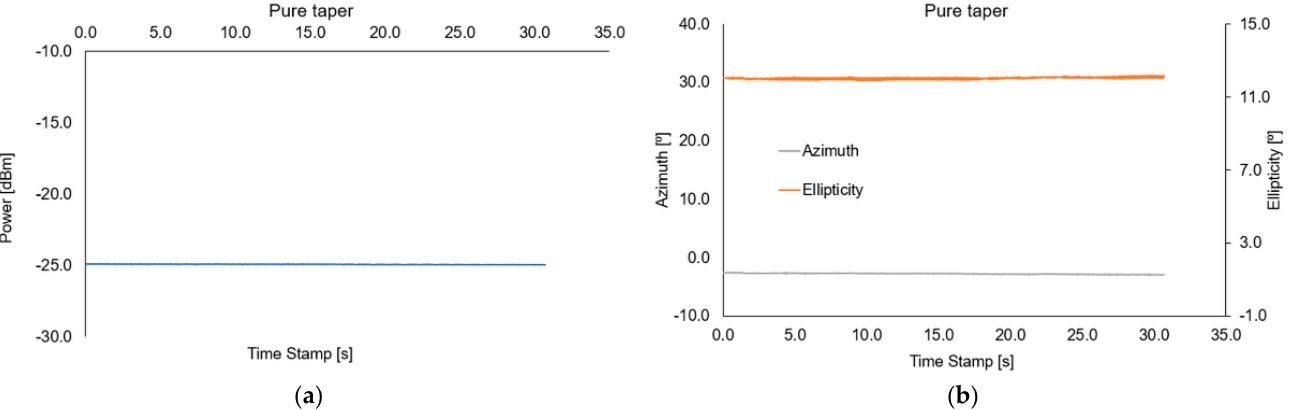
Figure 14. Reference graphs of ( a ) optical power, ( b ) azimuth and ellipticity parameters for the ta- pered optical fiber taper.